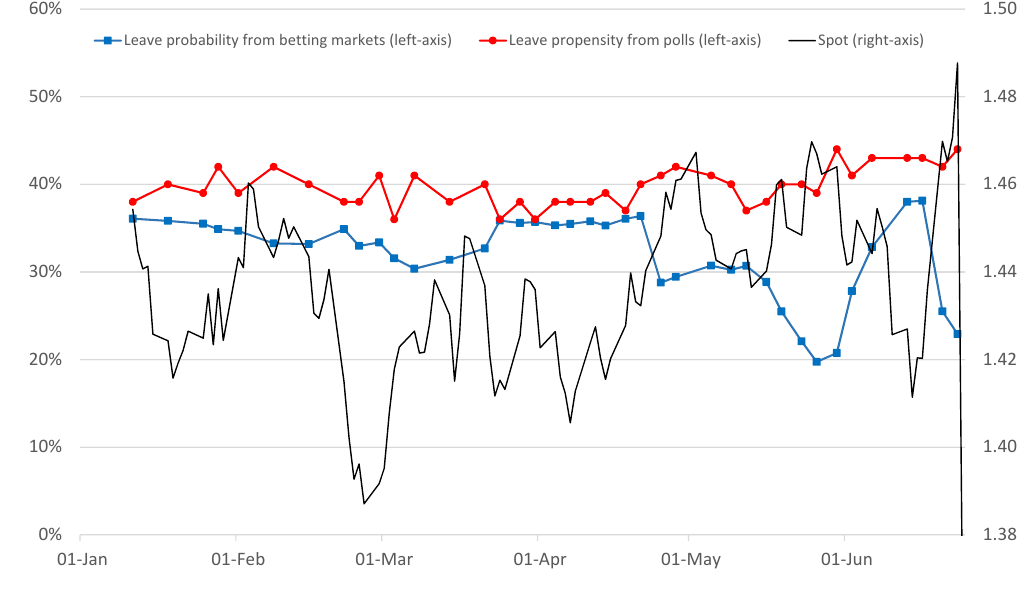
Figure 6. Historical time series of statistical indications for “leave” from referendum polls and betting odds, shown with GBPUSD FX spot rates (11 January to 23 June